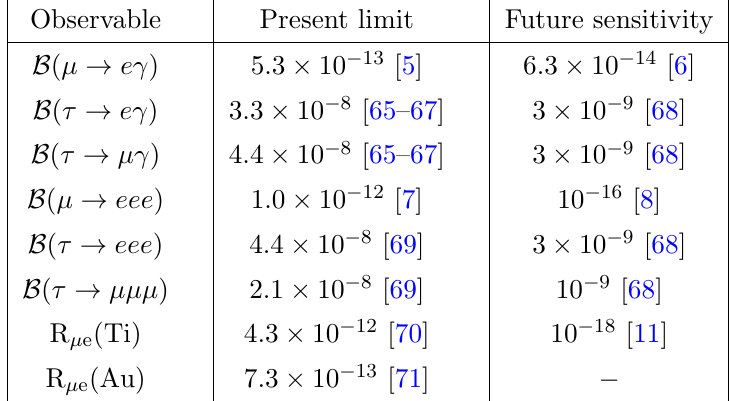
Table 1 . Current bounds and projected sensitivities for CLFV